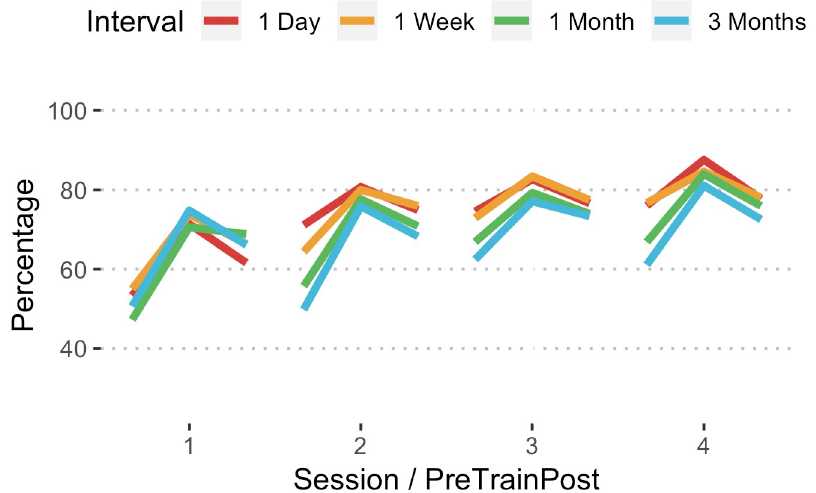
Fig 5. Mean percentage of ventilations with adequate volume by interval, session, and pretest/training/posttest assessment.